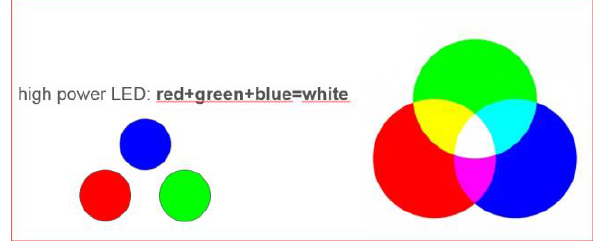
Figure 12d: Multi color projection – white